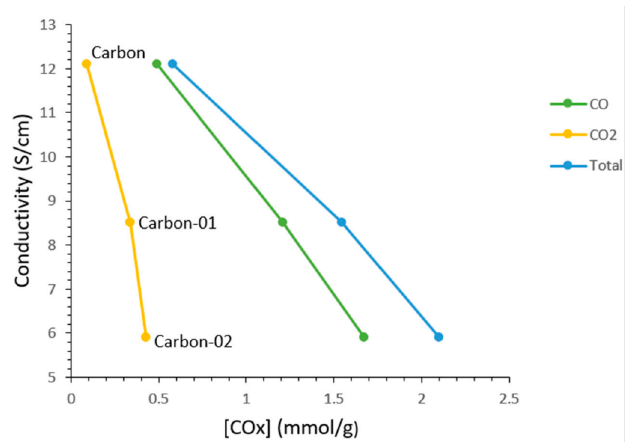
Figure 2. Conductivity vs. concentration of oxygen-containing functional groups of carbon black under various modification conditions. carbon-01: modified with 100 mL H 2 O 2 ; carbon-02: modified with 150 mL H 2 O 2 .